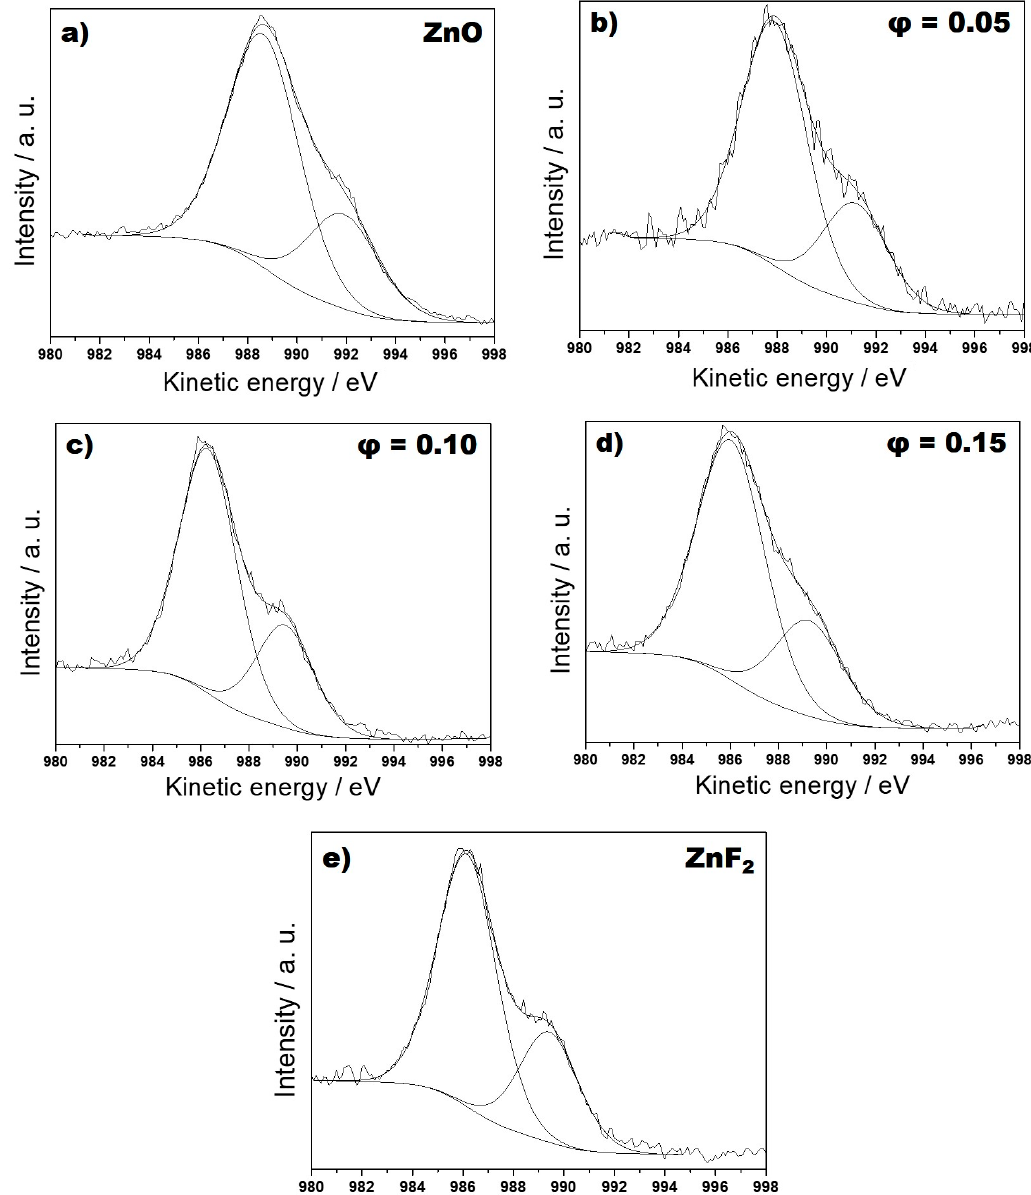
Figure 4. ZnL 3 M 45 M 45 XP-high resolution regions of ZnO-CF x nanocomposites having an inorganic phase volume fraction of φ = 0.05 ( b ); φ = 0.10 ( c ); and φ = 0.15 ( d ). The same region for a pure ZnO film ( a ) and a ZnF 2 standard ( e ) is also reported, for comparison.